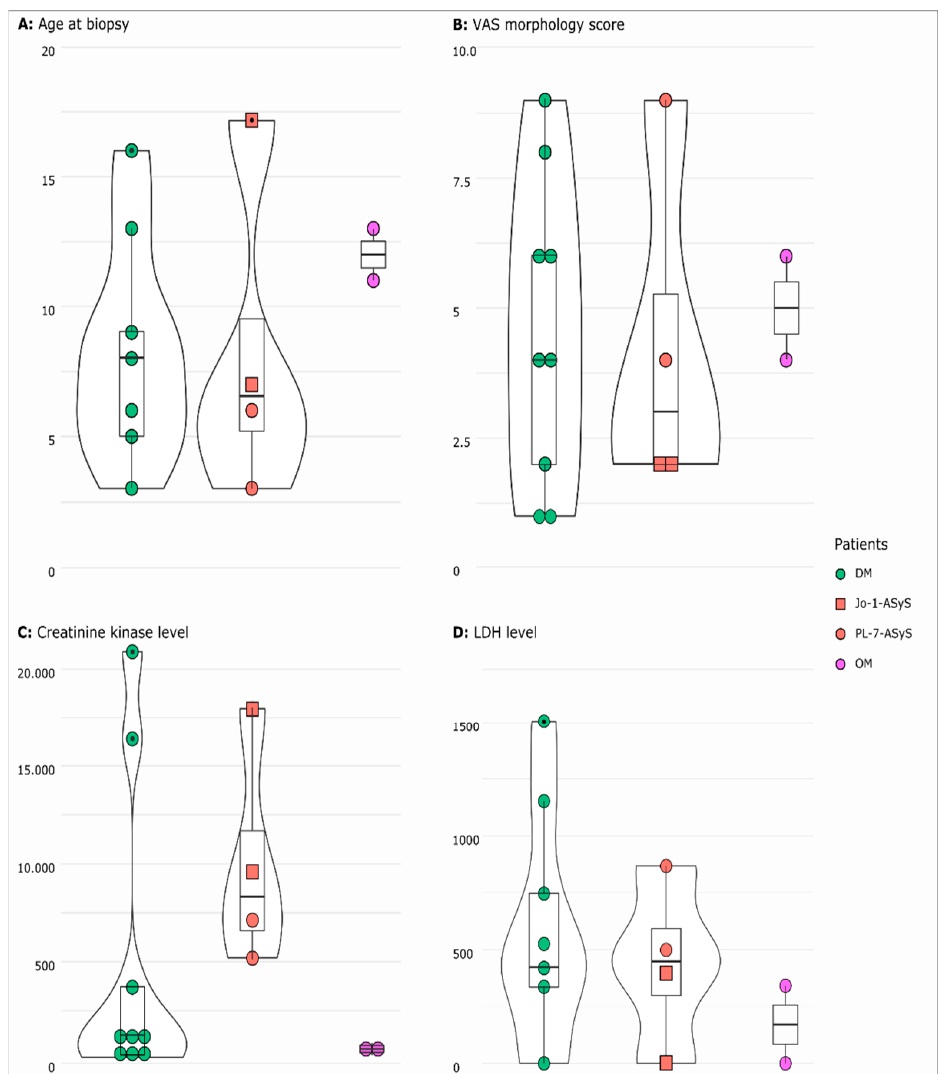
Figure 1. Distribution as violin plot (rotated kermel density curve and boxplot) of age at biopsy ( A ) VAS morphology score ( B ), serum creatine kinase ( C ), and LDH ( D ) levels in jIIM subgroups DM, ASyS (Jo-1, PL-7), and OM. Wide sections represent a higher probability that the patients take the value and small sections represent a lower probability. The box represents the interquartile range, the whiskers minimum (Q1 − 1.5 × IQR) and maximum (Q3 + 1.5 × IQR), and the points show the outliers. For all parameters, the p-value did not reach statistical significance. (DM = dermatomyo- sitis; ASyS = antisynthetase syndrome; OM = overlap myositis).